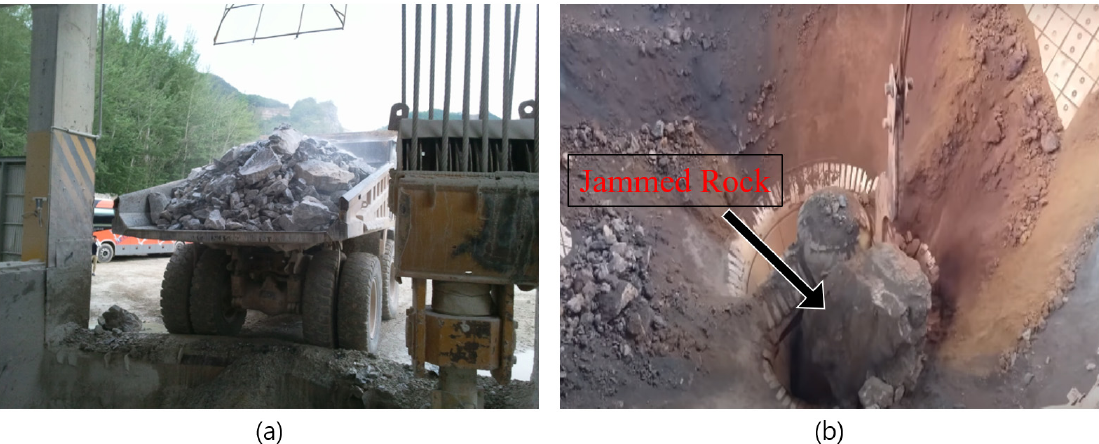
Figure 1. Illustration of ( a ) dispensing rocks from a truck and ( b ) a jamming